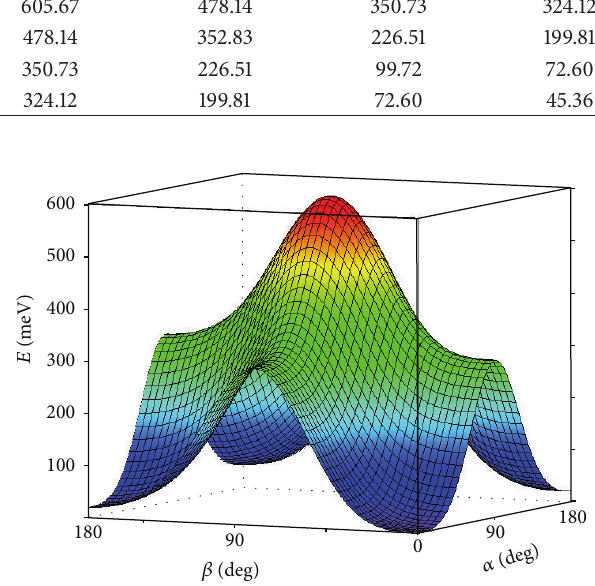
Figure 2: Two-dimensional potential energy surface of the BCNDTS molecule as a function of the two angles 𝛼 and 𝛽